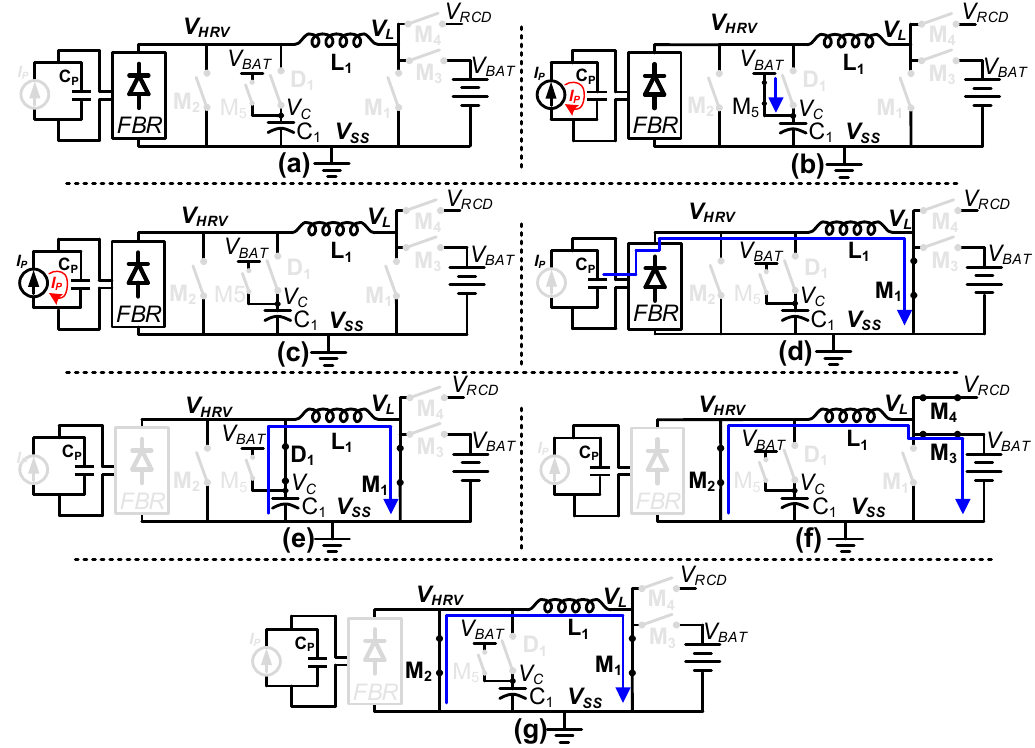
Figure 3. Proposed harvesting interface operation states ( a ) Standby; ( b ) Precharge; ( c ) Voltage peak detection; ( d ) Inductor charging; ( e ) Free-wheeling; ( f ) Battery charging; ( g ) Reset.